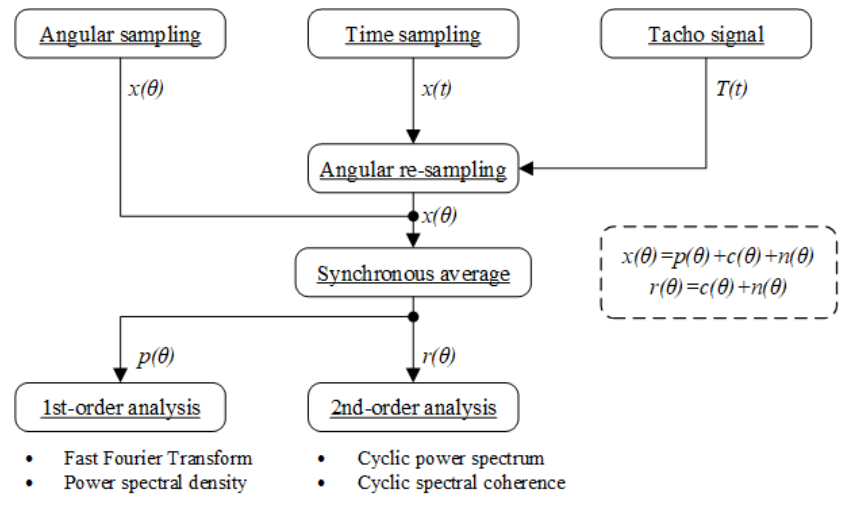
Figure 1. Block diagram of the proposed approach for the analysis of acceleration